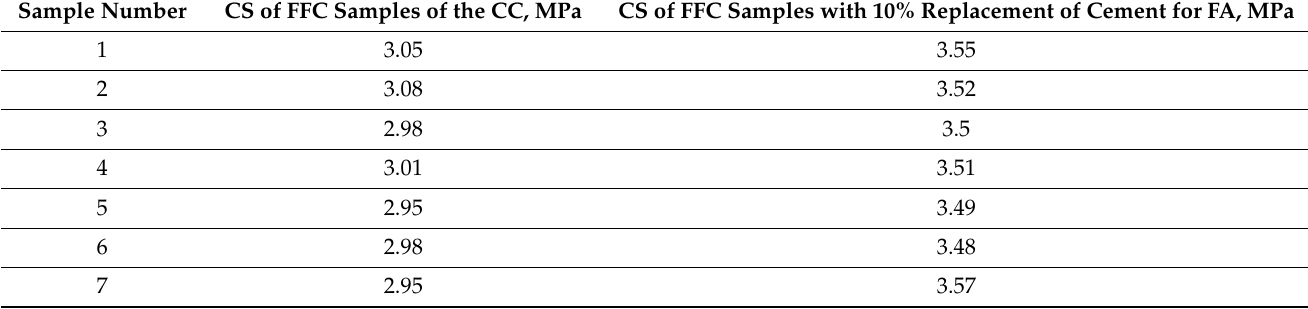
Table 13. Results of determining the CS of the main